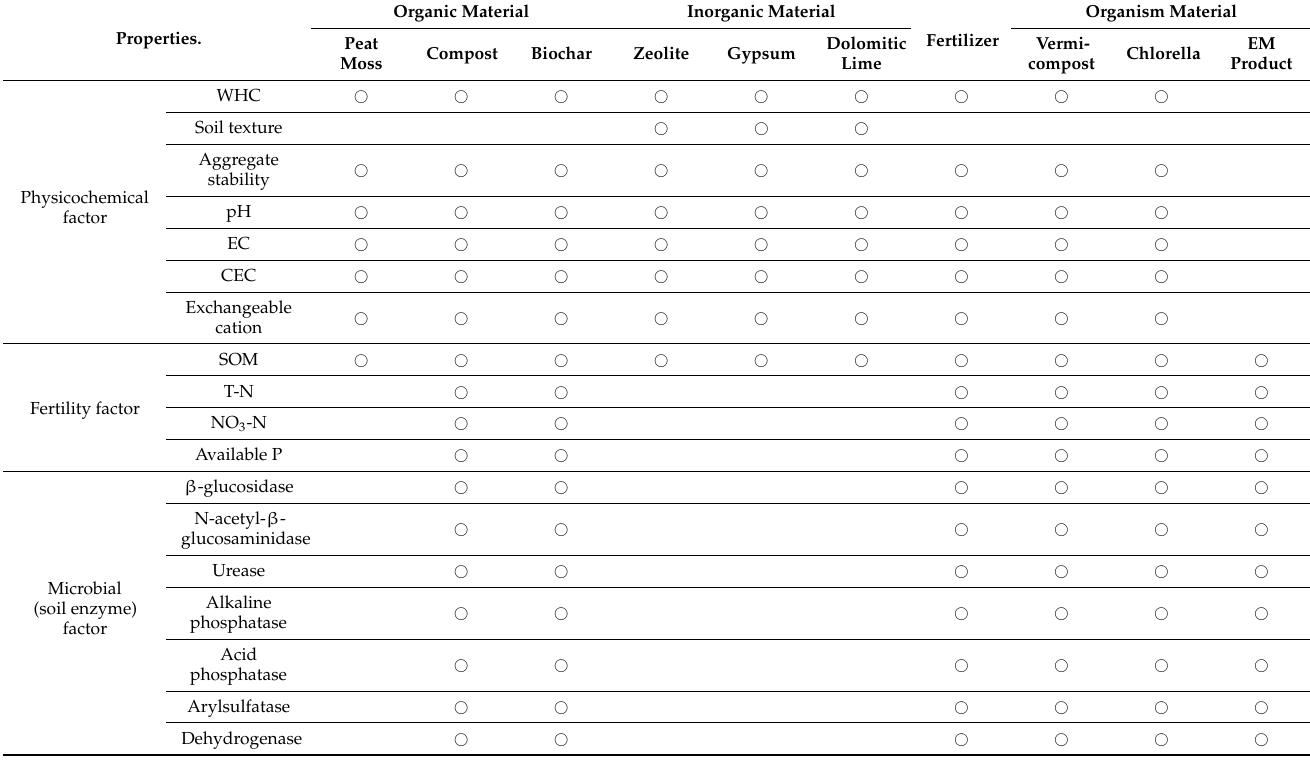
Table 2. Properties of each material monitored during the restoration